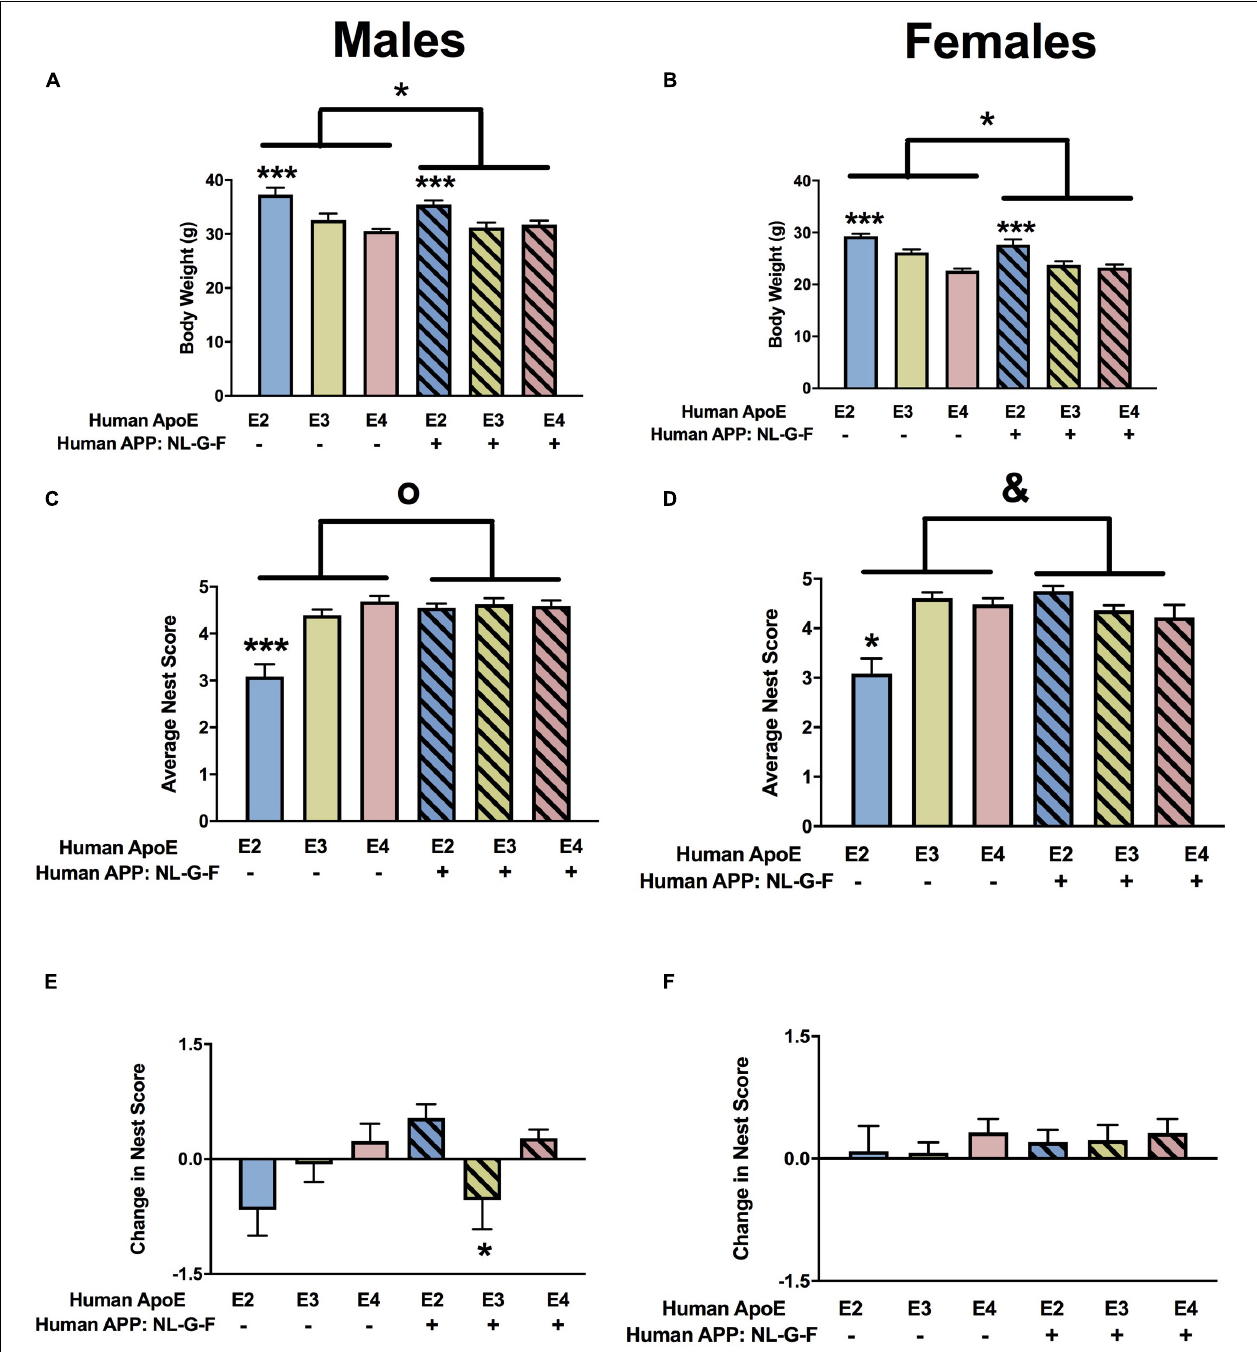
FIGURE 1 | Body weights and nest score measures in males (A,C,E) and females (B,D,F) at the 6-month time point. (A) There was an effect of APOE and APP on body weights in males. E2 males were heavier than E3 and E4 males. *** p < 0.001. Mice were lighter in the presence of NL-G-F (mean body weights males; mAPP: 32.65 g; NL-G-F: 31.6 g; mean body weights females; mAPP: 25.8 g; NL-G-F: 24.4 g). * p < 0.05. (B) There was an effect of APOE and APP on body weights and an APP × APOE interaction in females. E2 males were heavier than E3 and E4 females. *** p < 0.001. Mice were lighter in the presence of NL-G-F. * p < 0.05. (C) There was an effect of APOE and APP and an APP × APOE interaction for nest scores in males. Nest score were lower in E2 than E3 and E4 males. *** p < 0.001. Nest score were higher in the presence of NL-G-F. o p < 0.001. This was most profound in the E2 background. (D) There was an effect of APOE and APP and an APP × APOE interaction for nest scores in females. Nest score were lower in E2 than E3 and E4 females. * p < 0.05. Nest score were higher in the presence of NL-G-F. o p < 0.001. This was most profound in the E2 background. & p = 0.013. (E) There was an APP × APOE interaction for the change in nest scores in males. The change in nest score was worse in NL-G-F/E3 than NL-G-F/E2 or NL-G-F/E4 mice. * p < 0.05. (F) There were no effects on the change in nest scores in females.